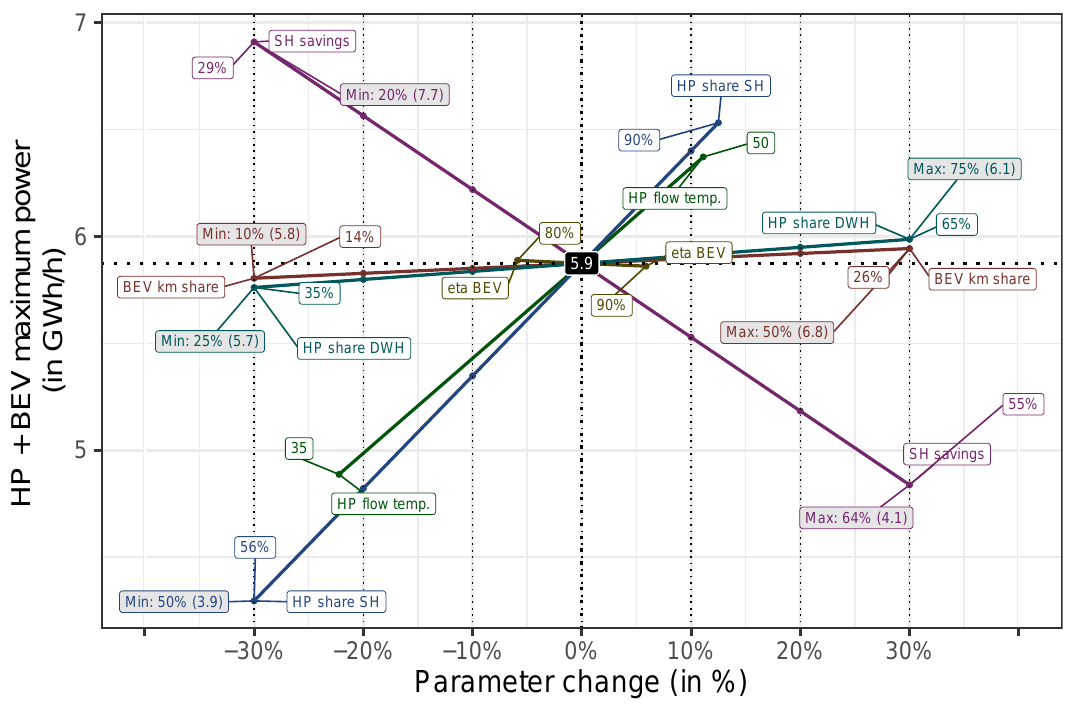
Figure 14. Sensitivity plot of the additional maximum power demand of heat pumps and BEV with respect to plausible percentage changes of the key parameters in Table 3.